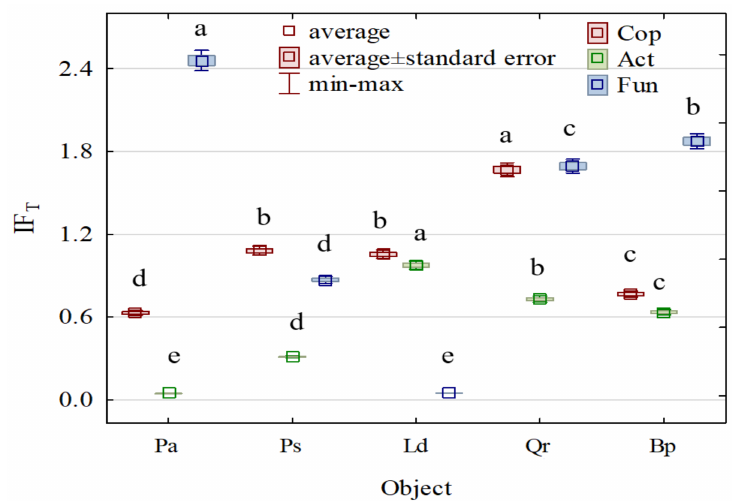
Figure 3. The index of the stand influence on the number of microorganisms. Pa— Picea abies L., Ps— Pinus sylvestris L., Ld— Larix decidua M., Qr— Quercus robur L., Bp— Betula pendula L., Cop— copiotrophic bacteria, Act—actinomycetes, and Fun—fungi. Homogeneous groups (denoted with letters a–e) were calculated separately for each